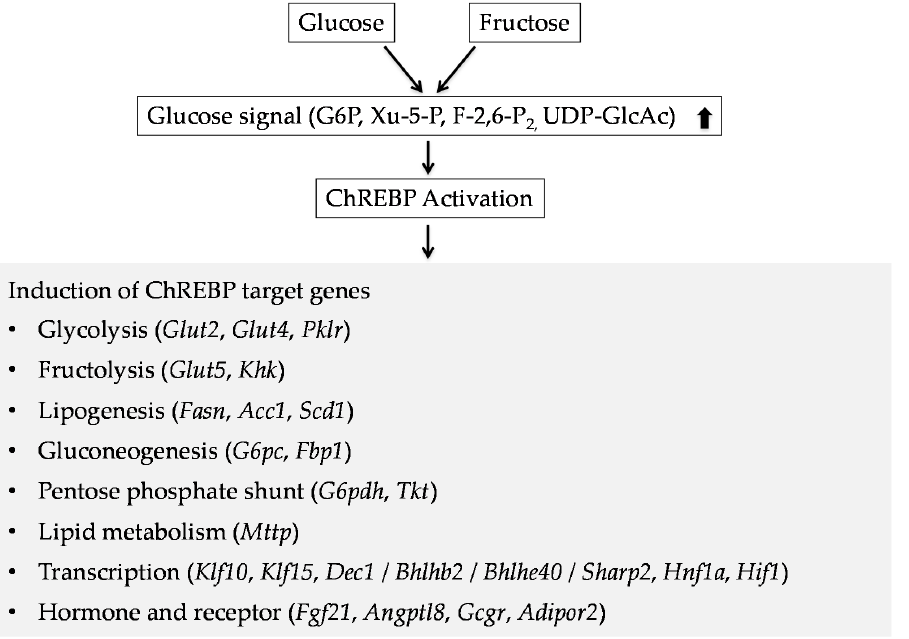
Figure 4. ChREBP has an important role in regulating glucose and lipid metabolism. Glucose and fructose regulate many genes expression through ChREBP activation [14,20,23–25]. Glut2 , glucose transporter 2; Glut4 , glucose transporter 4; Pklr , pyruvate kinase, liver and red blood cell; Glut5 , glucose transporter 5; Khk , ketohexokinase; Fasn , fatty acid synthase; Acc1 , acetyl coA carboxylase 1; Scd1 , stearoyl CoA desaturase; G6pc , glucose-6-phosphatase catalytic subunit; Fbp1 , fructose-1,6-bisphosphatase 1; G6pdh , hexose-6-phosphate dehydrogenase; Tkt , transketolase; Mttp , microsomal triglyceride transfer protein; Klf10 , kruppel-like factor 10; Klf15 , kruppel-like factor 15; BHLHE40 , basic helix-loop-helix family, member E40; Bhlhb2 , Basic helix-loop-helix domain-containing protein, class B; Hnf1a , hepatocyte nuclear factor 1a; Hif1 , hypoxia inducible factor 1; Fgf21 , fibroblast growth factor 21; Angptl8 , angiopoietin like 8; Gcgr , glucagon receptor; Adipor2 , adiponectin receptor